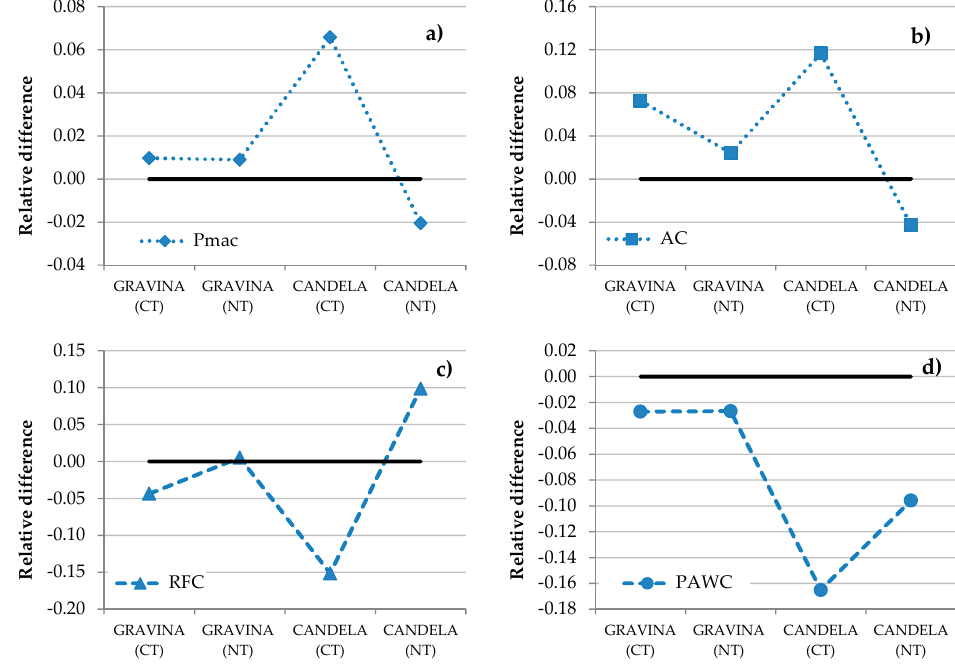
Figure 9. Relative differences between measured mean values and optimal mean values for macroporosity ( a ), air capacity ( b ), relative field capacity ( c ) and plant available water capacity ( d ), according to the Table 1.